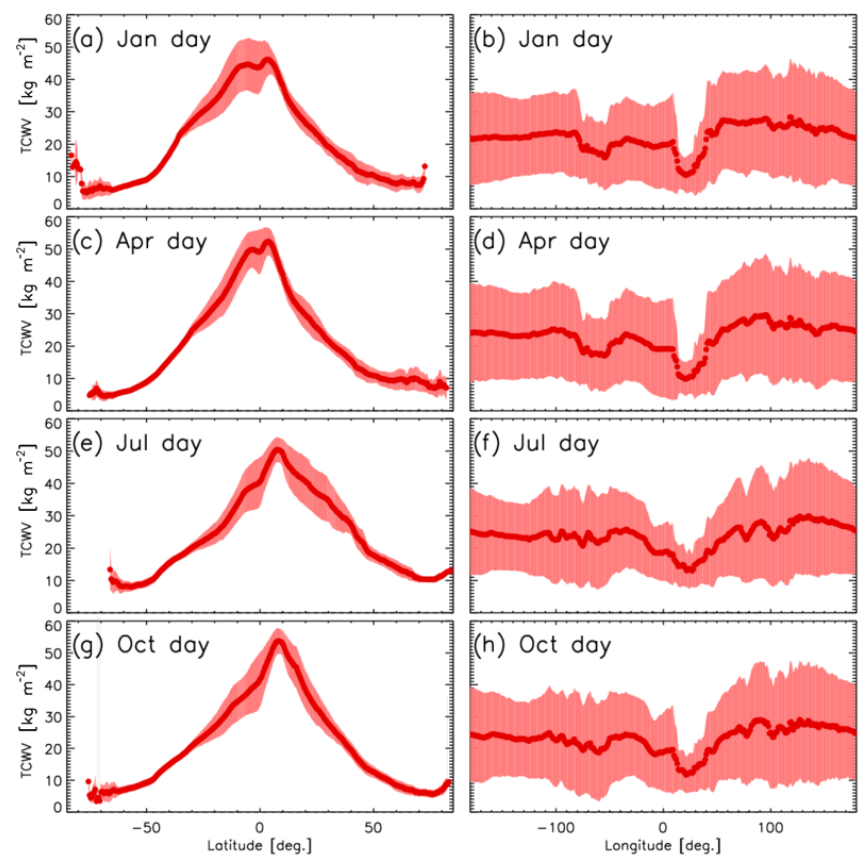
Figure 4. TCWV distribution as function of latitude (median and standard deviation) (a, c, e, g) and as function of longitude (b, d, f, h) .